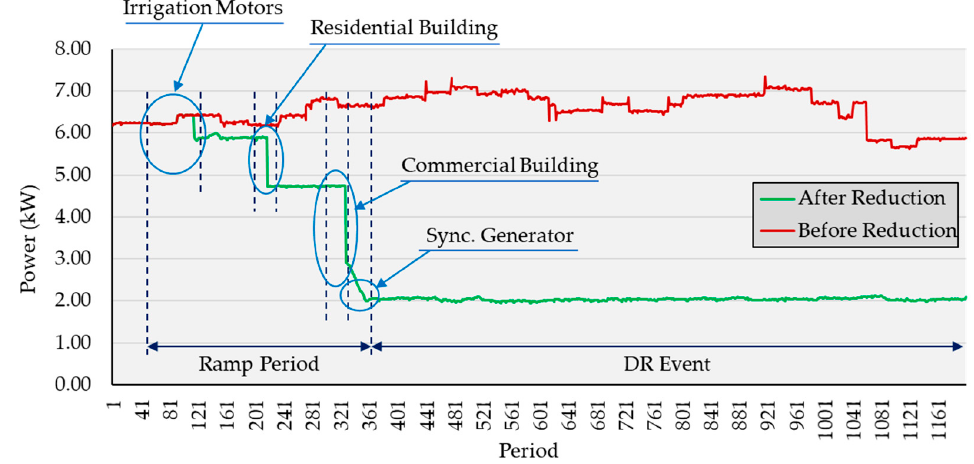
Figure 9. Experimental results adapted from the emulators during the case study.